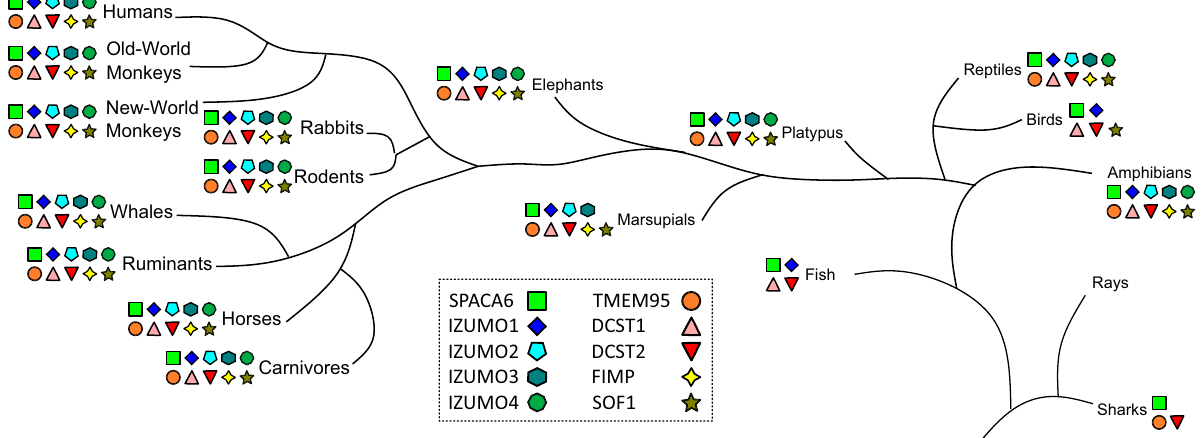
Fig. 4 Distribution of gamete fusion-associated proteins throughout the tree of life. PSI-BLAST searches using SPACA6, IZUMO1-4, TMEM95, DCST1, DCST2, FIMP, and SOF1 of the NCBI database were used to determine where in the tree of life these sequences are found. Distances between branch points are not drawn to scale.